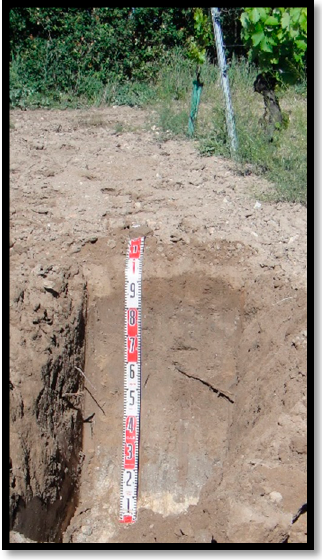
Figure 2. View of the selected soil profile. Table 1. General description and macromorphological characteristics of the researched soil (Villanueva de Alcardete, To- ledo).